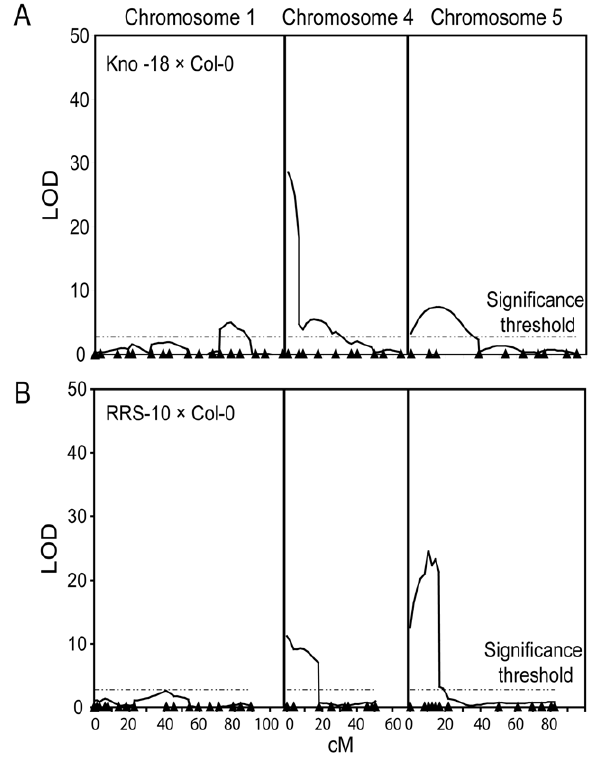
Figure 4. QTL analysis of vernalization requirement and response in two accessions from N. America. QTL were found on chromosome 1, 4, and 5 (chromosomes 2 and 3 not shown). Dashed line shows 5 % significance threshold, as calculated from a 1000 permutation test. The positions (in cM) of the markers used are indicated as triangles. (A) KNO-18 6 Col F2 population scored for flowering time without vernalization. (B) RRS-10 6 Col F2 population scored for flowering time after 8 weeks of vernalization.